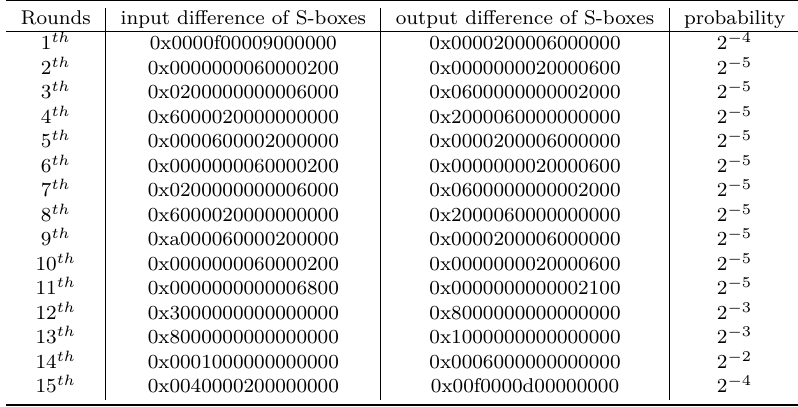
Table 12: The best differential characteristic with probability 2 − 66 for 15-round RECT-